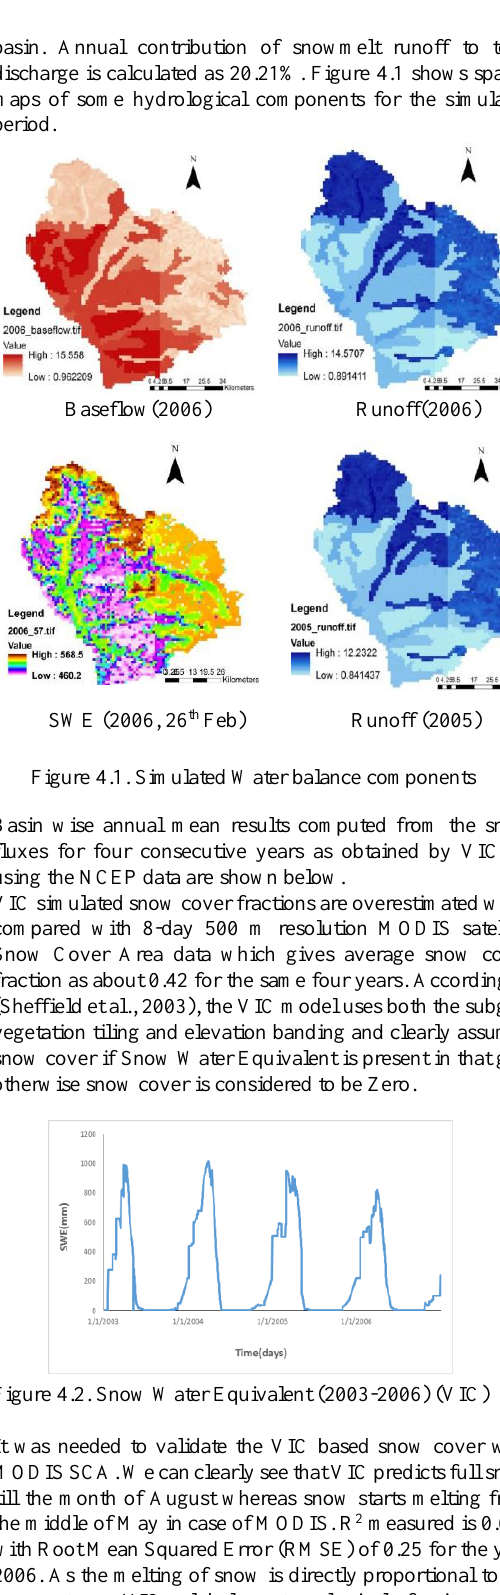
Figure 4.3. Snow Melt (2003-2006) (VIC)